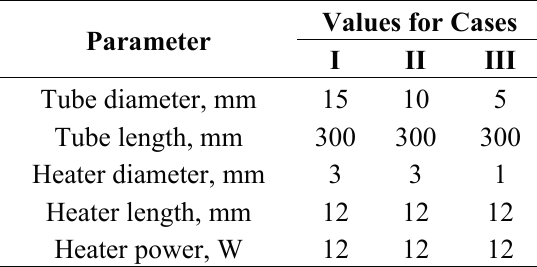
Table 2. TAF construction